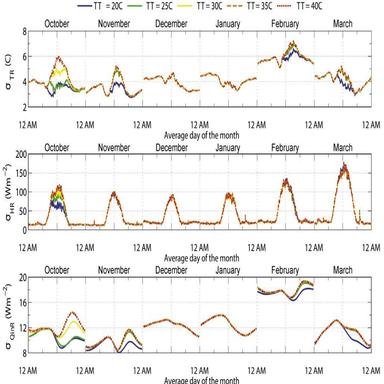
Cumulative number of thermochromic triggering (top) and percentage of time at α = 0.55 (bottom) for the five considered transition temperatures, i.e. 20, 25, 30, 35 and 40 °C in each of the simulated month.